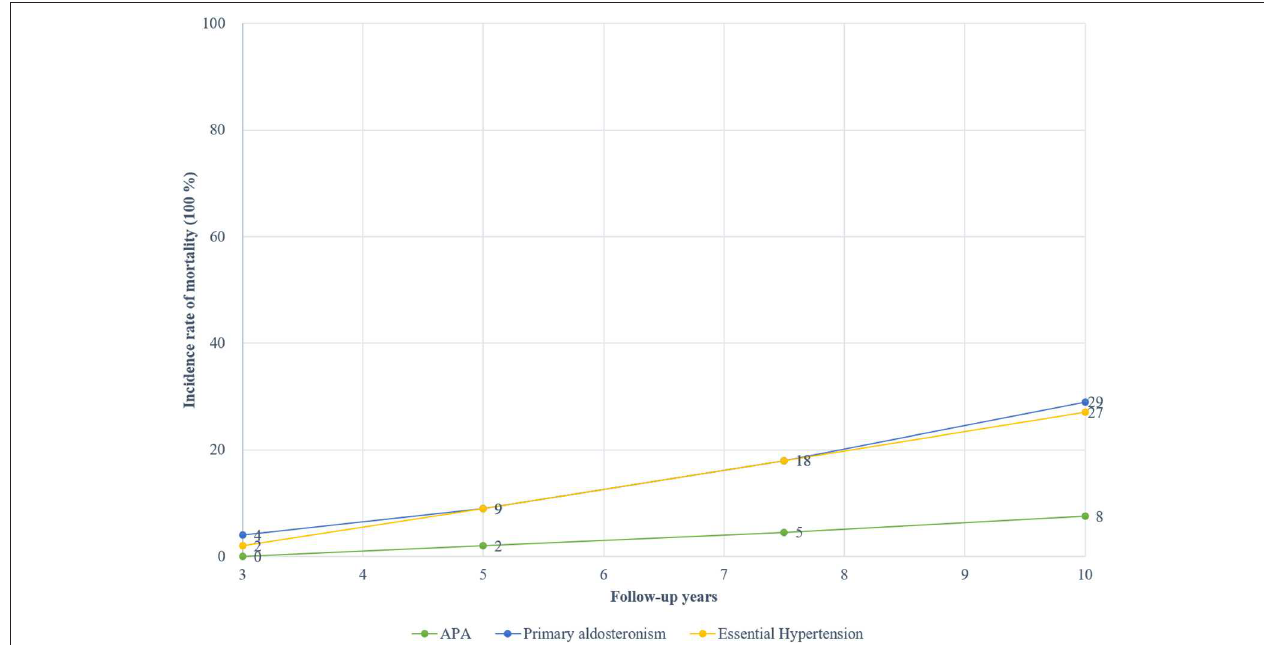
FIGURE 5 | The absolute incidence of death of patient with PA and EH at different follow-up times.